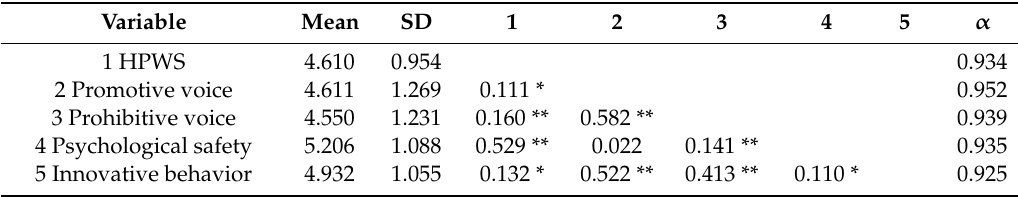
Table 2. Mean, standard deviation, and